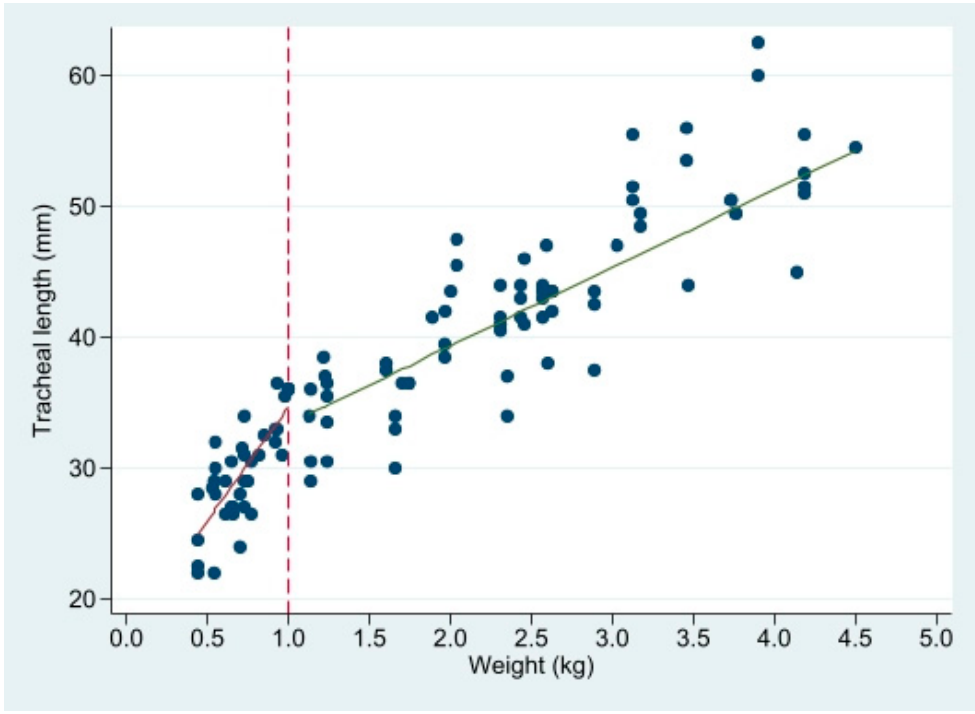
Figure 3. Linear regression of tracheal length (mm) on weight, in 2 segments with a node at 1 kg. See Table 1 for regression parameters.